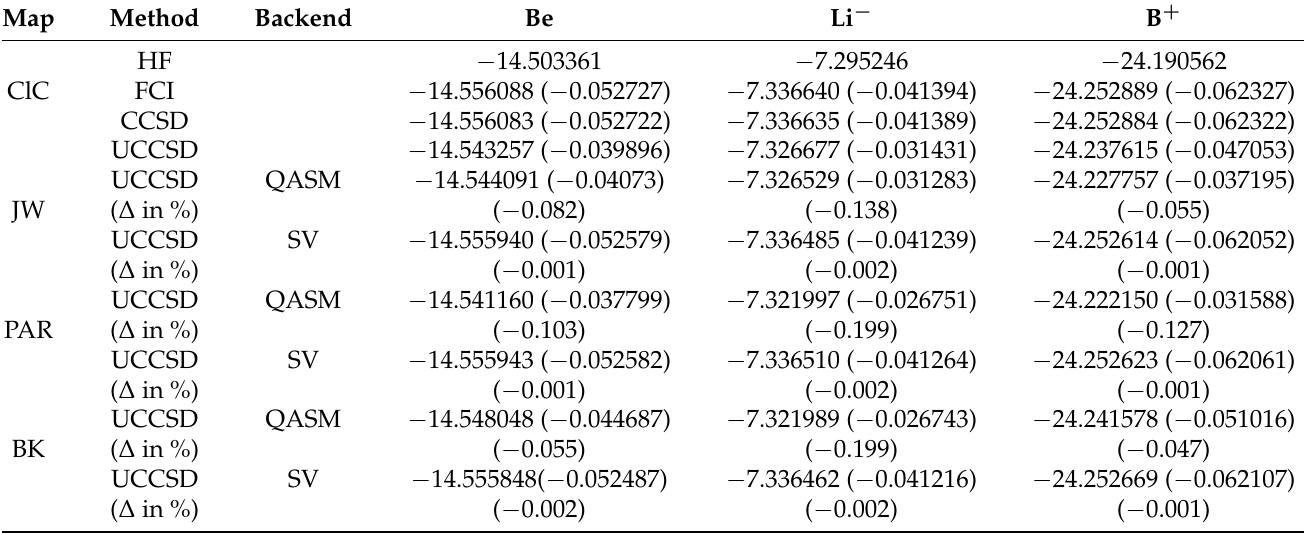
Table 2. The ground state energies of Be, Li − , and B + obtained using the STO-6G basis. All notations are the same as in Table